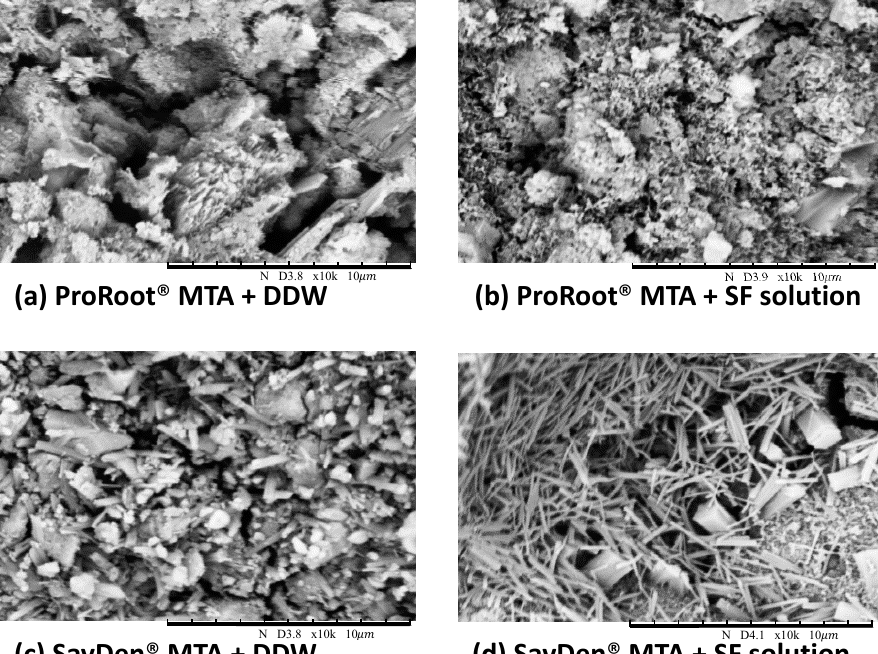
Figure 2. SEM micrographs of the cross-section area in various cement surfaces with the magnification of × 10,000. ( a ) ProRoot ® MTA + DDW has a larger particle size compared to those of ( b ) ProRoot ® MTA + SF solution. ( d ) SavDen ® MTA + SF solution contains additional amounts of cubic and needle-like structures, while ( c ) SavDen ® MTA + DDW has scattered particles compared to ( d ).